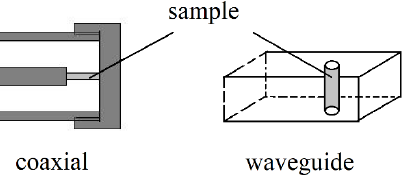
Figure 1. ( a , b ) Transmission/reflection and ( c , d ) reflection measurement cells.